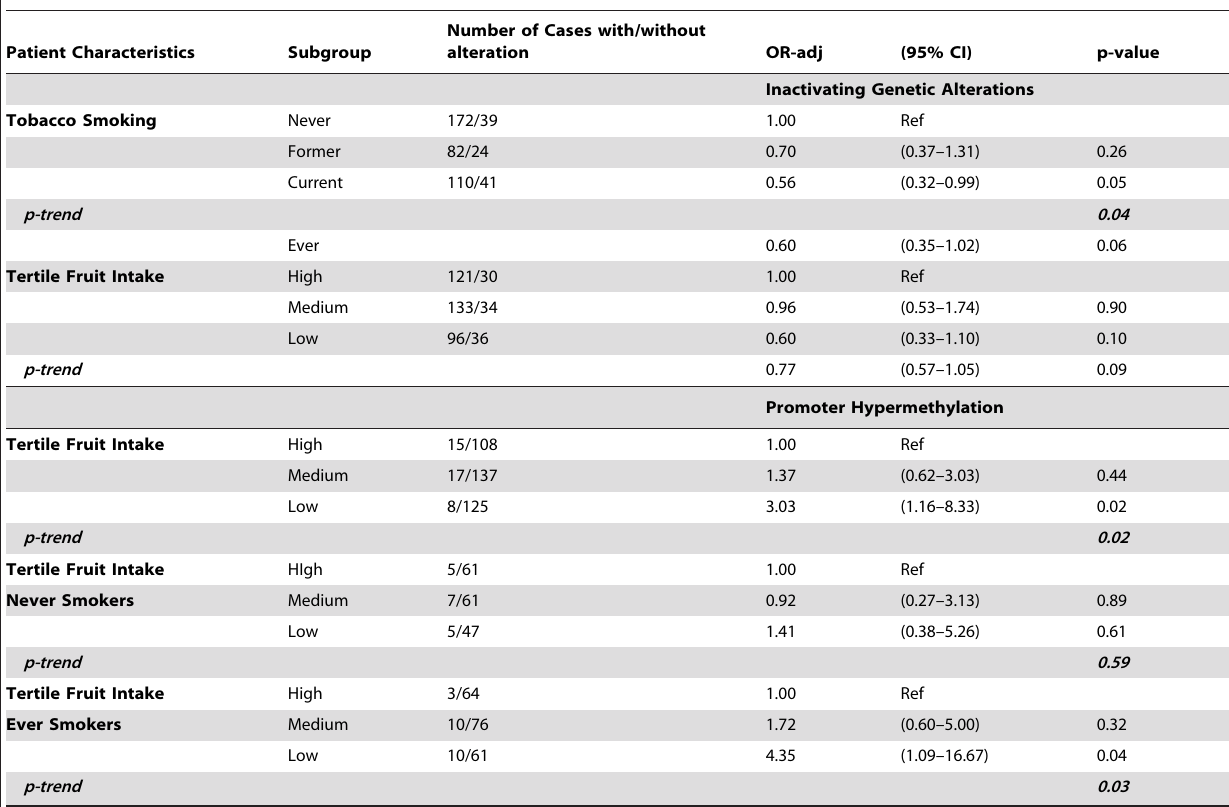
Table 2. Multivariate analysis of VHL inactivating alterations and ccRCC risk factors.